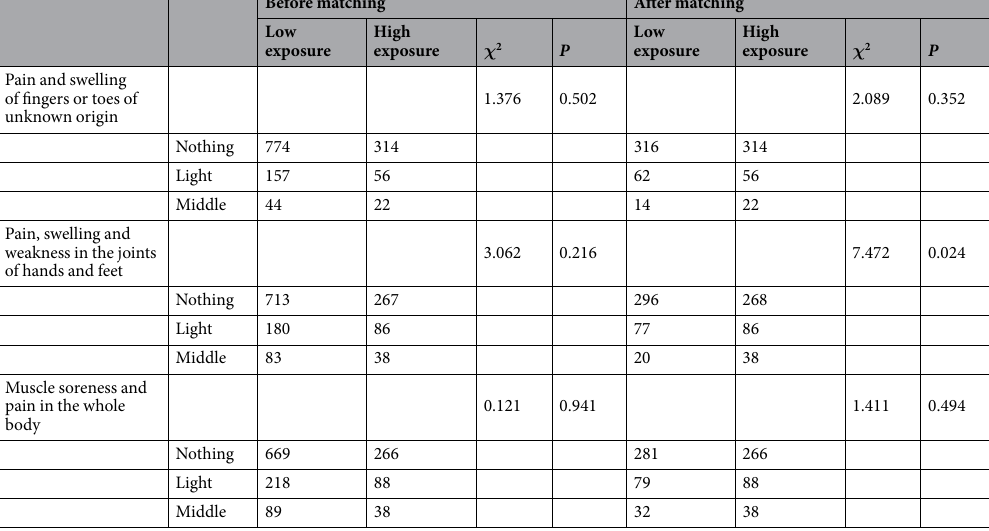
Table 7. Difference Test of Symptom Frequency in Skeletal muscle system before and after Matching.